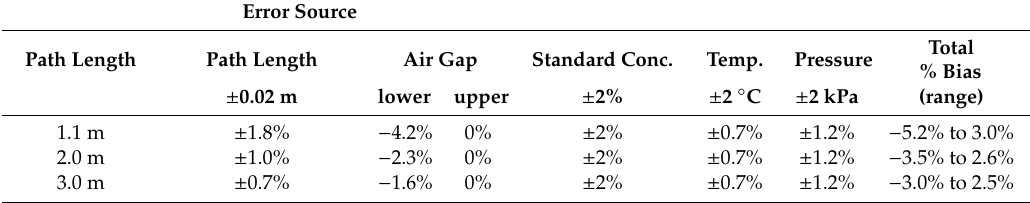
Table 1. Potential error contribution from uncertainty in measured path length, air gap in front of the laser, standard gas concentration, air temperature, and pressure. Error estimates are calculated for three path-lengths. Error related to a 5 cm air gap is calculated using ambient concentration of 1.8 ppm and the median standard gas concentration of 30.6 ppm (lower limit), while the upper limit assumes no ambient air mixed in the